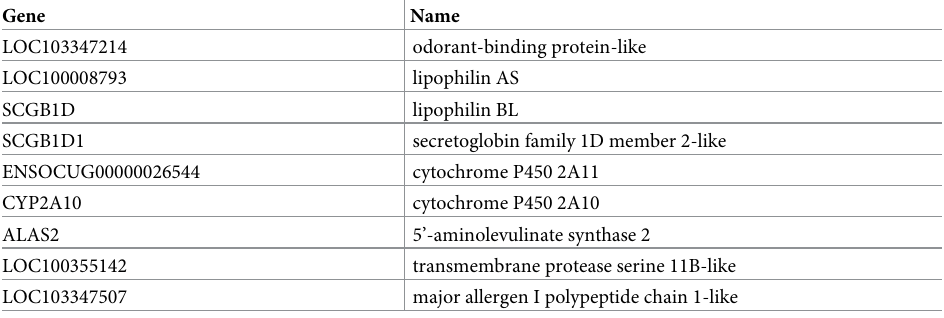
Table 4. Putative rabbit DED transcript markers not previously correlated with the